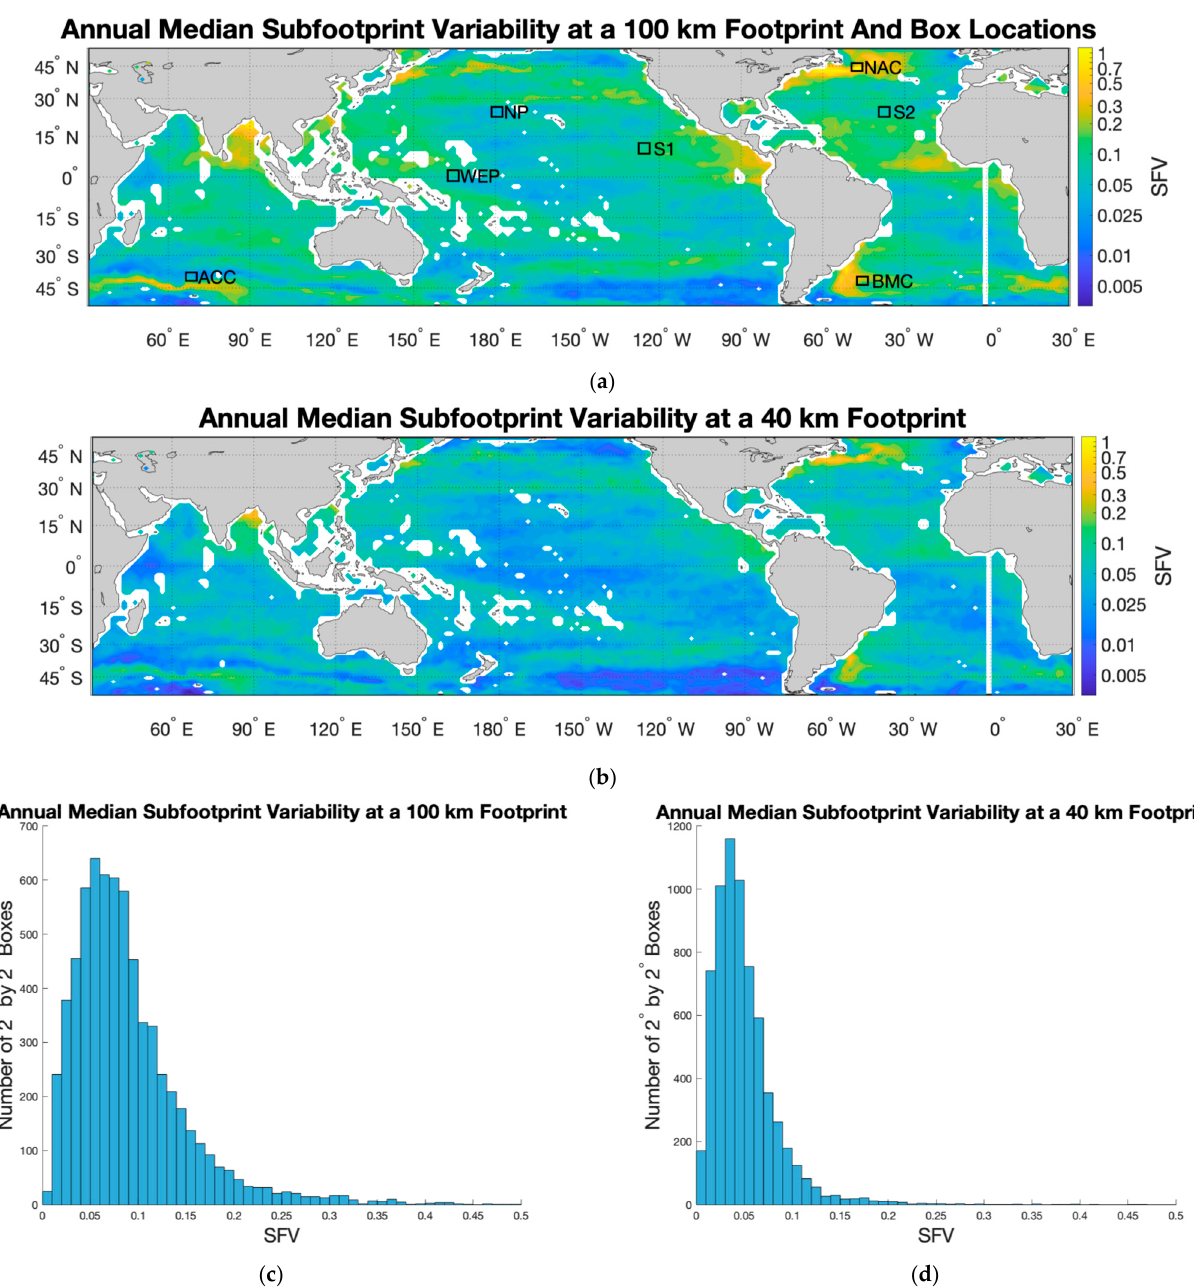
Figure 2. ( a ) Median SSS SFV, i.e., σ 50 , for a 100 km footprint for the whole year. Unitless color scale is at right, with the colors scaling as the base 10 logarithm of the SFV. Boxes with labels in various locations are keys to the curves shown in Figure 4. The boxes are 4° × 4° in size, with SFV values averaged within the boxes. ( b ) Same for 40 km, but with no boxes. ( c , d ) Display the same median SFV median values as histograms which count the number of 2° × 2° boxes with the given SFV. The total number of boxes in both figures is 10,440. Note different y-axis limits in panels ( c , d ). Note that the mid-ocean blank spaces in panels ( a , b ) are due to small islands within the 2° × 2° boxes.